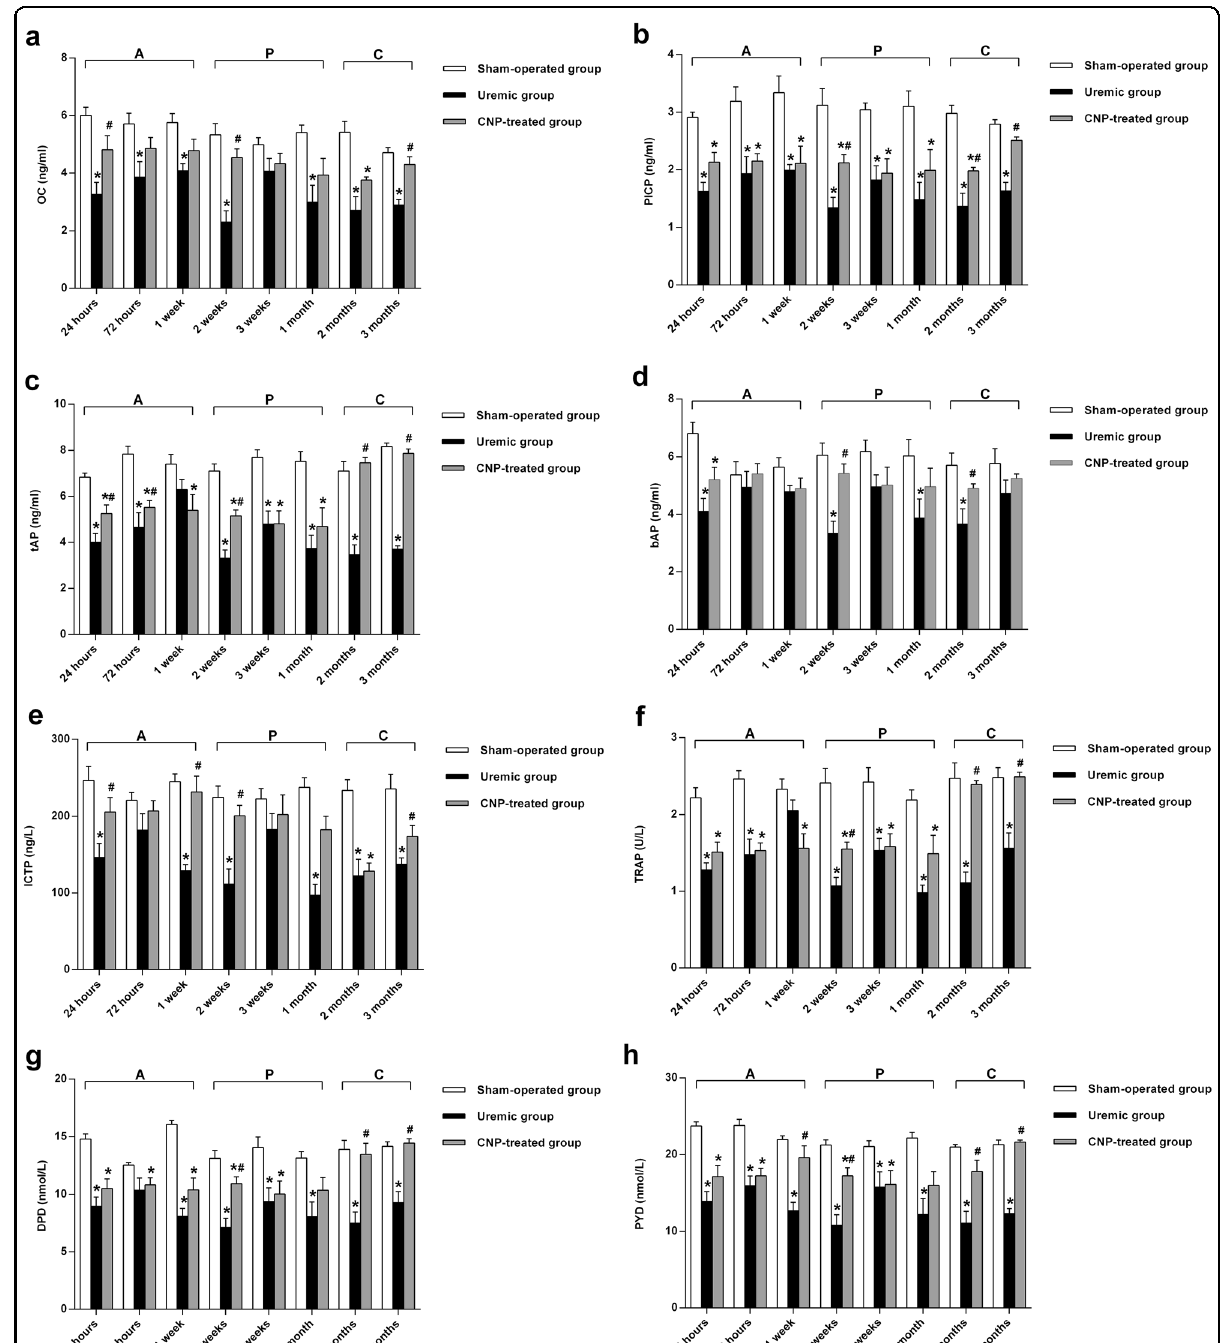
Fig. 4 Biochemical markers of bone turnover in sham-operated, uremic, and CNP-treated rats. Uremic group vs sham-operated group: Osteoblastic (OC, PICP, tAP, and bAP) and osteolytic (ICTP, TRAP, PYD, and DPD) proteins were remarkably different between the two groups, and the uremic group developed signi fi cantly lower levels of bone turnover markers during this study ( a – h ); CNP-treated group vs. uremic group: Signi fi cant higher levels of OC, tAP, ICTP, and PYD were noted in the CNP-treated group in each stage ( a , c , e , h ); PICP, bAP, TRAP, and DPD increased signi fi cantly in the CNP-treated group from the progressive stage to the chronic stage ( b , d , f , g ). CNP-treated group vs. sham-operated group : in the CNP-treated group, the levels of osteoblastic (OC, PICP, tAP, and bAP) and osteolytic (TRAP, PYD, and DPD) biomarkers eventually increased to levels comparable to those in the sham-operated group at 3 months postoperatively ( a – d , f – h ); the ICTP level was signi fi cantly lower than that in the sham-operated group in the chronic stage ( e ). * P < 0.05, signi fi cantly different from the corresponding sham-operated group; # P < 0.05, signi fi cantly different from the corresponding uremic group. A acute stage, P progressive stage, and C chronic stage